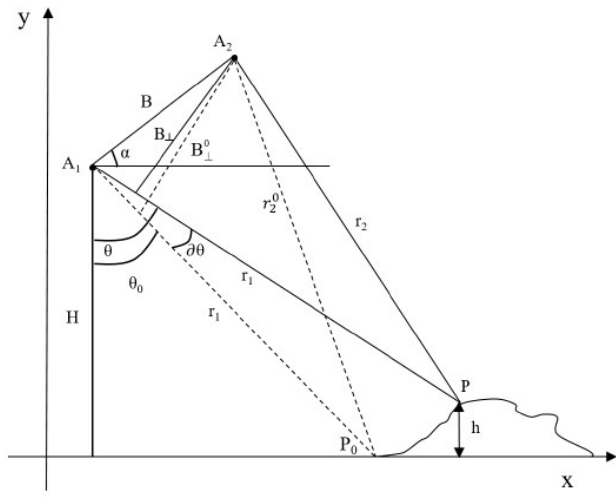
Figure 7. Geometric relations for SAR interferometry.